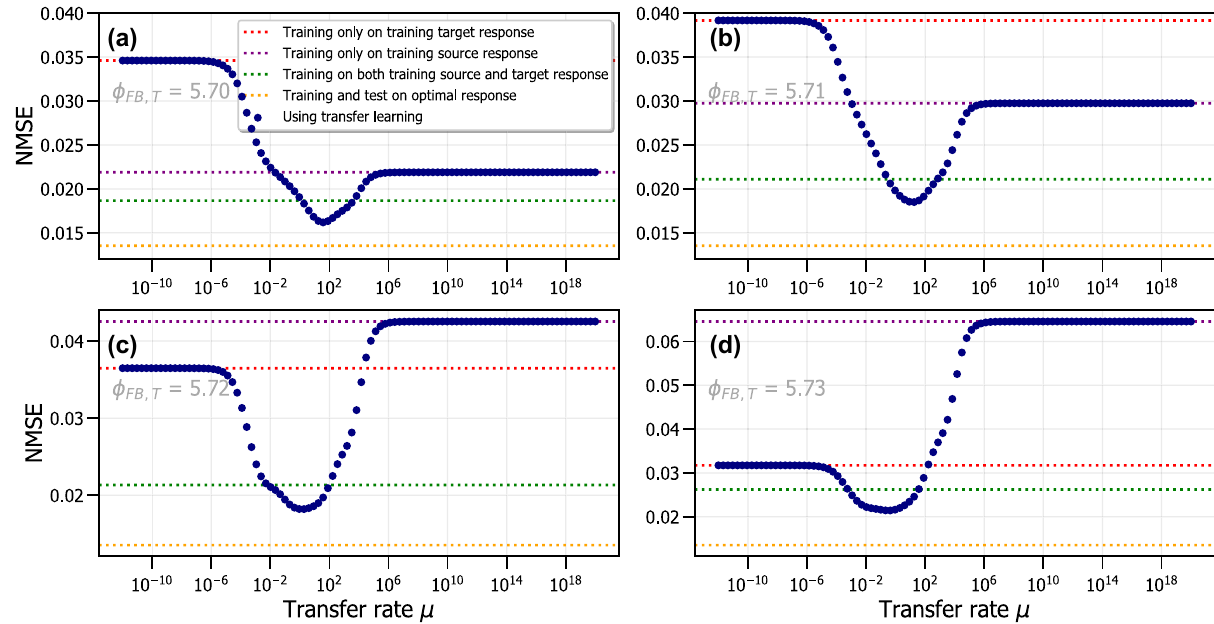
= 5.68 and four training target responses FB , S = 5.70 (a), 𝜙 = 5.71 (b), 𝜙 = 5.72 (c) and 𝜙 = 5.73 FB , T FB , T FB , T FB , T